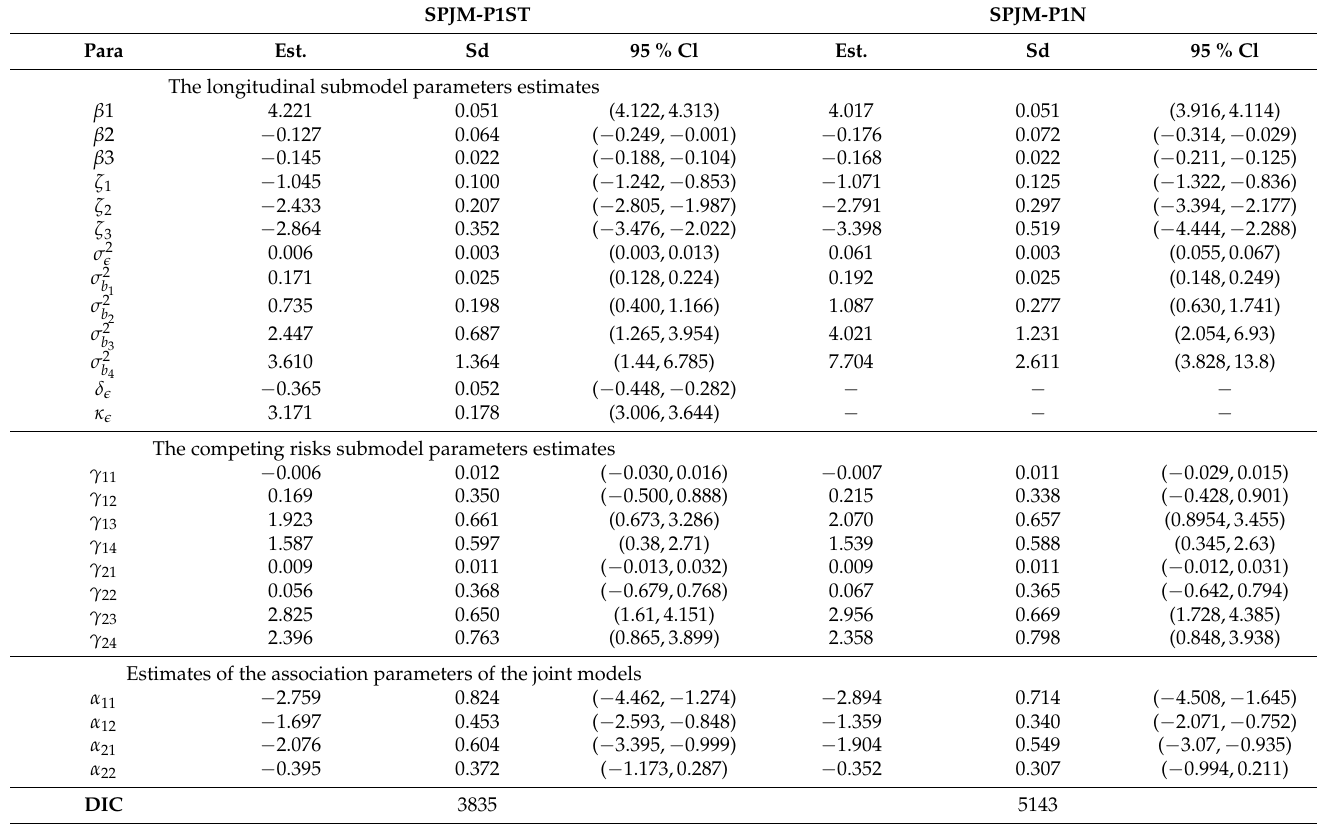
Table 3. The posterior mean estimates (Est), standard deviation (Sd), and 95% credible interval (CI) for the parameters from the selected joint model SPJM-P1 with different distributions. SPJM-P1ST